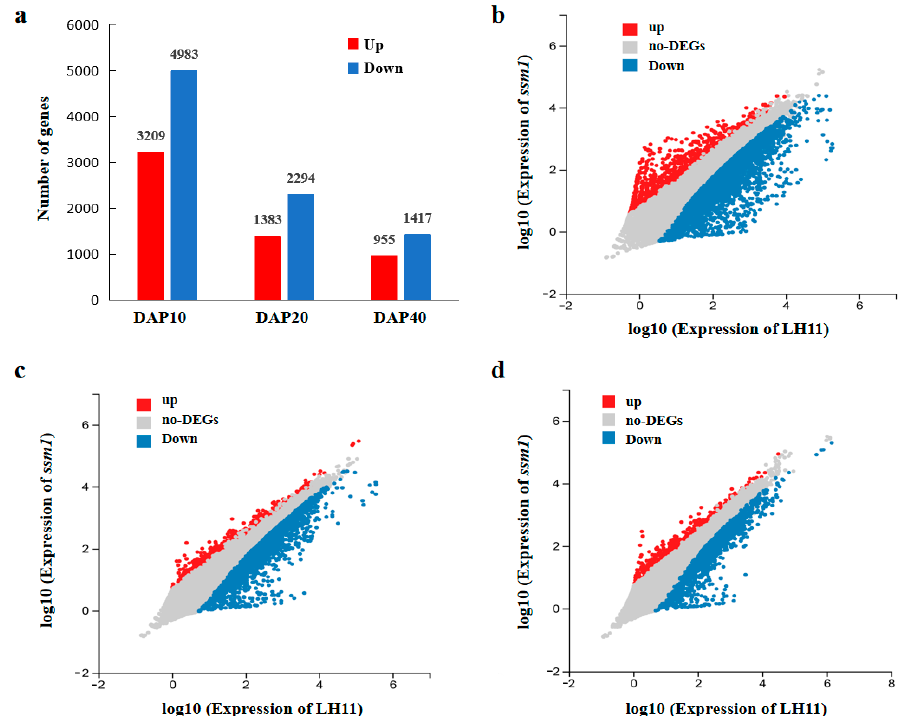
Figure 4. Comparison of DGEs between ssm1 and LH11 seeds. ( a ) Numbers of DGEs in seeds between ssm1 and LH11 at DAP10, DAP20, and DAP40 three stages; ( b ) Scatter diagram of DEGs in seeds at DAP10 between ssm1 and LH11; ( c ) Scatter diagram of DEGs in seeds at DAP20 between ssm1 and LH11; ( d ) Scatter diagram of DEGs in seeds at DAP40 between ssm1 and LH11. Both the X and Y axes represent log10 values of gene